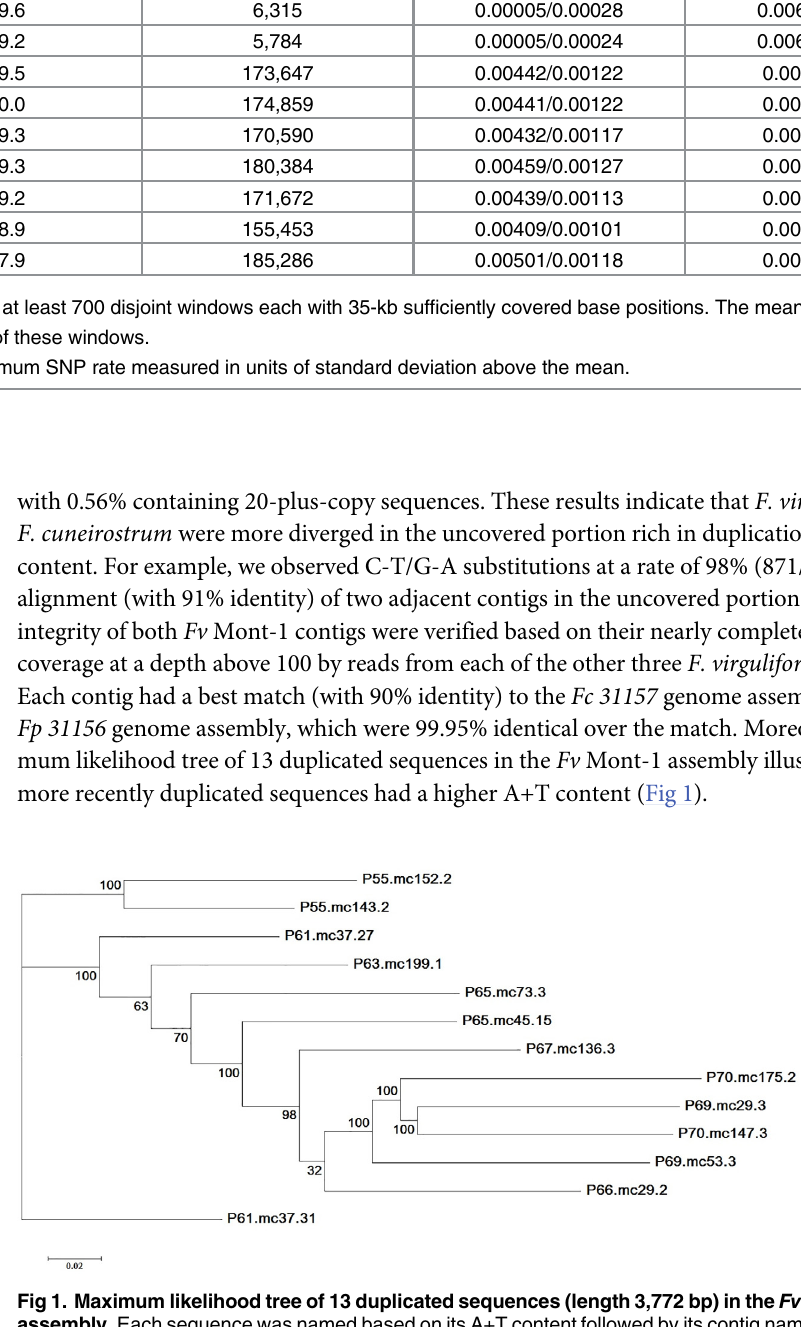
Fig 1. Maximum likelihood tree of 13 duplicated sequences (length 3,772 bp) in the Fv Mont-1 assembly. Each sequence was named based on its A+T content followed by its contig name. For example, sequence P61.mc37.31 indicates an A+T content of 61% and mc37.31 as its source contig. The four most recently duplicated sequences were P69.mc53.3, P70.mc175.2, P69.mc29.3 and P70.mc147.3, with the highest A+T content range of 69% to 70%. Support values from 100 bootstrap replicates are provided at